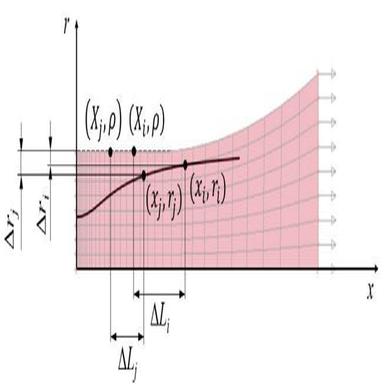
Scheme for the target definition: correlation between the reference and the deformed configurations in terms of points coordinates.